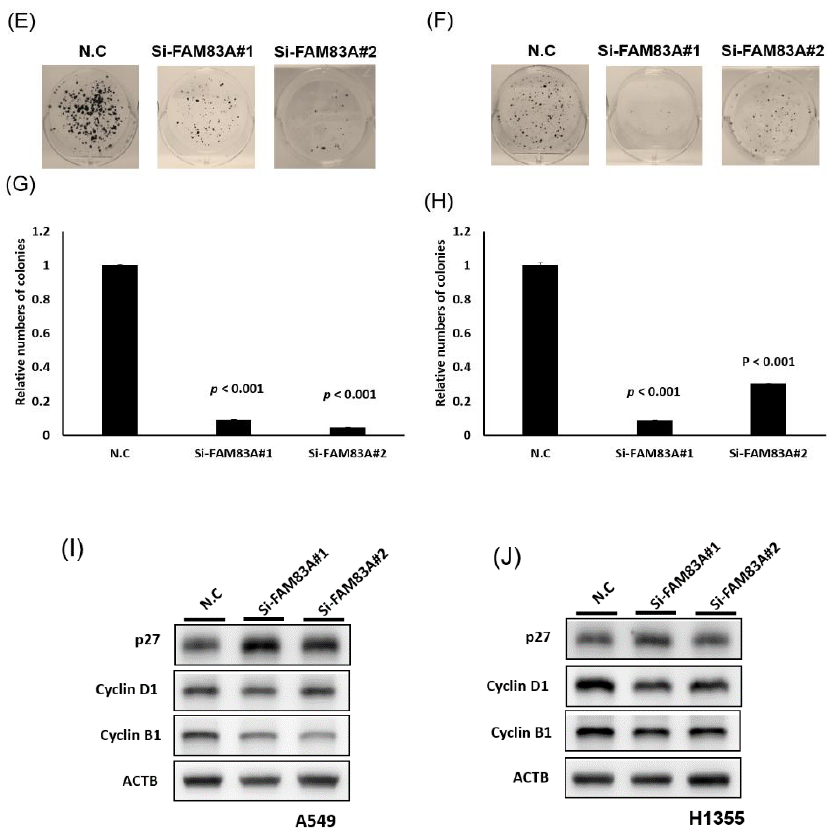
Figure 3. Suppression of lung cancer cell growth and motility by FAM83A knockdown. ( A , B ) FAM83A expression levels in A549 and H1355 cells knocked down using siRNA transfection by real-time reverse transcription polymerase chain reaction. ( C , D ) Cell proliferation in A549 and H1355 cells with FAM83A knockdown. ( E – H ) Quantification of colony formation ability of the A549 and H1355 cells. ( I , J ) Western blot analysis of expression levels of cell cycle–related genes in the A549 and H1355 cells. N.C. indicates a random siRNA sequence control. All experiments were performed in triplicate, and the data were analyzed using Student’s t test. Differences were considered significant when p < 0.05.